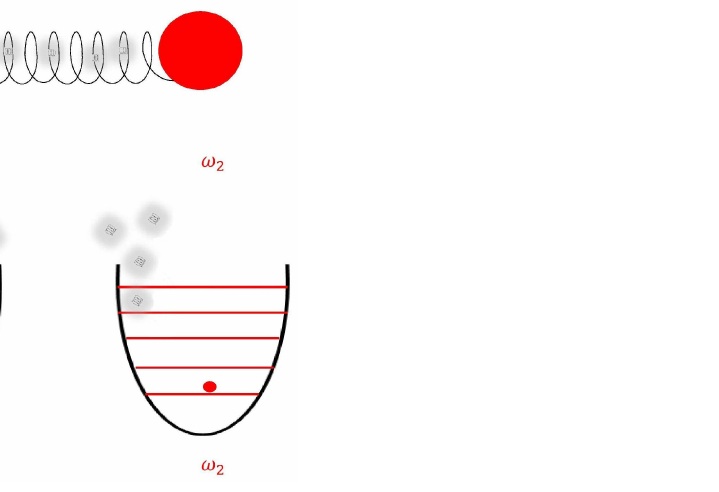
Figure 1. Two coupled oscillators via a position–position type coupling of the form x 1 x 2 . The dynamics generates virtual excitations (VE) that affect quantum